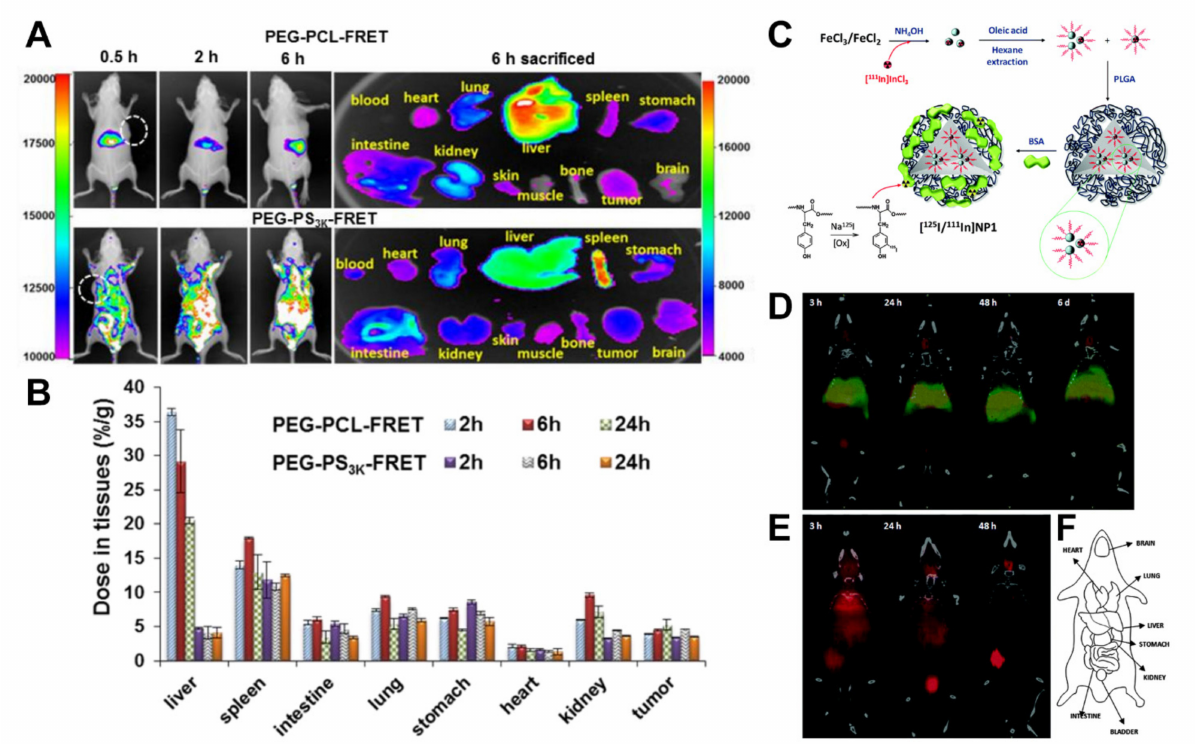
Figure 3. ( A ) In vivo behaviour of two different polymeric micelles (PEG-PCL and PEG-PS) by FRET. PEG-PCL with its PCL end conjugated with a FRET pair of Cy5 (donor) or Cy5.5 (acceptor). Mice were i.v. injected with PEG-PCL-FRET at 10 mg/kg and imaged at 0.5, 2, and 6 h and then sacrificed and dissected. Reproduced with permission from [114]. Copyright 2018 American Chemical Society. ( B ) The polymer concentration in each tissue was analysed. Data are reported as the mean (SD) for triplicate samples. The imaging was taken by the FRET fluorescence (Ex/Em = 640 nm/720 nm). Reproduced with permission from [114]. Copyright 2018 American Chemical Society. ( C ) Schematic of the preparation of dual-labelled [ 125 I/ 111 In]NP1 NPs. Reproduced with permission from [125]. Copyright 2015 Royal Society of Chemistry. ( D ) Coronal SPECT images of the biodistribution of [ 125 I/ 111 In]NP1 and ( E ) [ 125 I]BSA after intravenous administration into mice; red colour: 125 I; green colour: 111 In. Images were co-registered with a CT image of the same animal to anatomically localize the SPECT signal. CT images were adjusted in the Y axis at each time point for appropriate fitting with the tracer distribution image. Reproduced with permission from [125]. Copyright 2015 Royal Society of Chemistry. ( F ) A schematic of the different organs. Reproduced with permission from [125]. Copyright 2015 Royal Society of